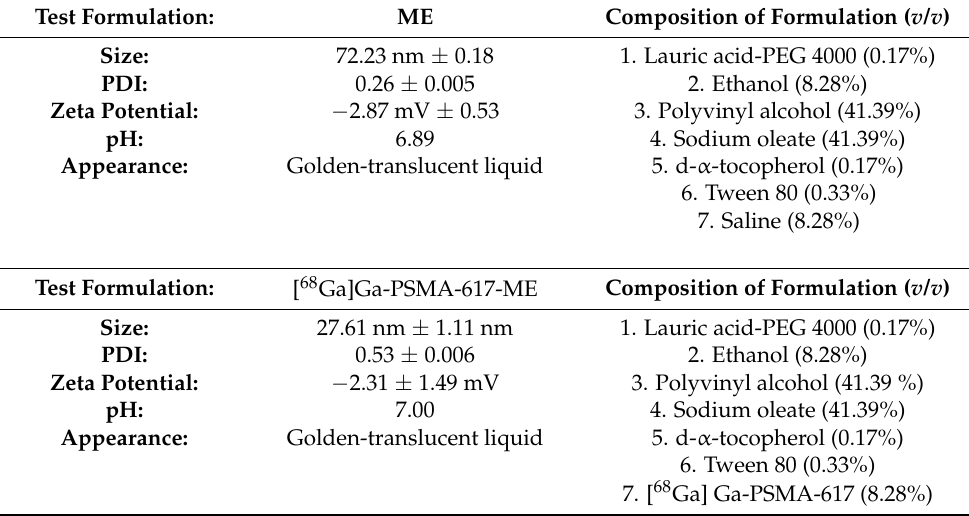
Table 4. Specifications of the microemulsion formulations employed in the toxicity